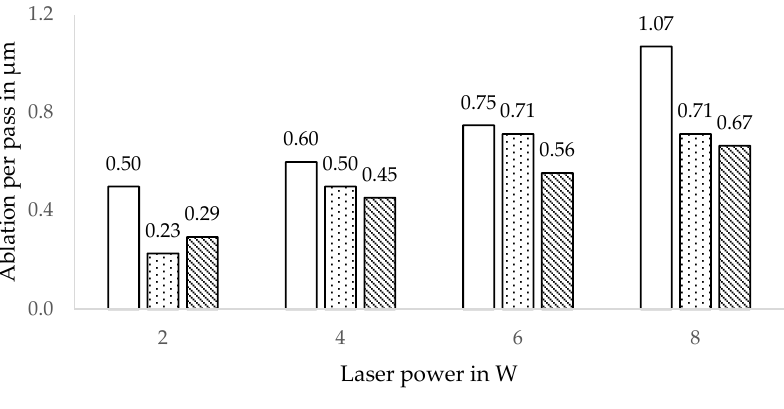
Figure 5. Nickel thickness ablated in one pass depending on laser power and nickel layer thickness. The cut width for these data points is 100 µ